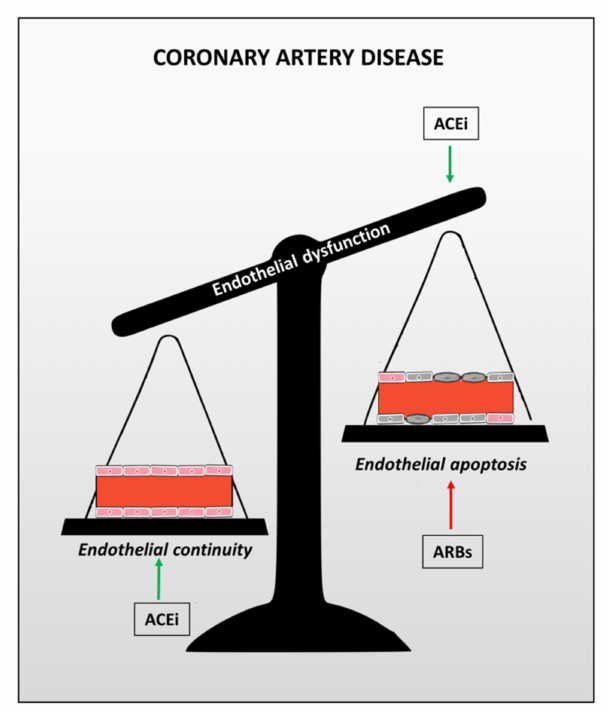
Figure 1. Opposite effects of ACE inhibitors (ACEi) and angiotensin II receptor blockers (ARBs) on endothelial function. Conversely, ACE inhibition reduces cell death (apoptosis) and extends the lifecycle of endothelial cells. Thus, these drugs maintain endothelial continuity and exert protection against acute coronary syndromes and cardiovascular mortality beyond blood pressure reduction. However, ARBs appear to exert a pro-apoptotic effect on vascular endothelial